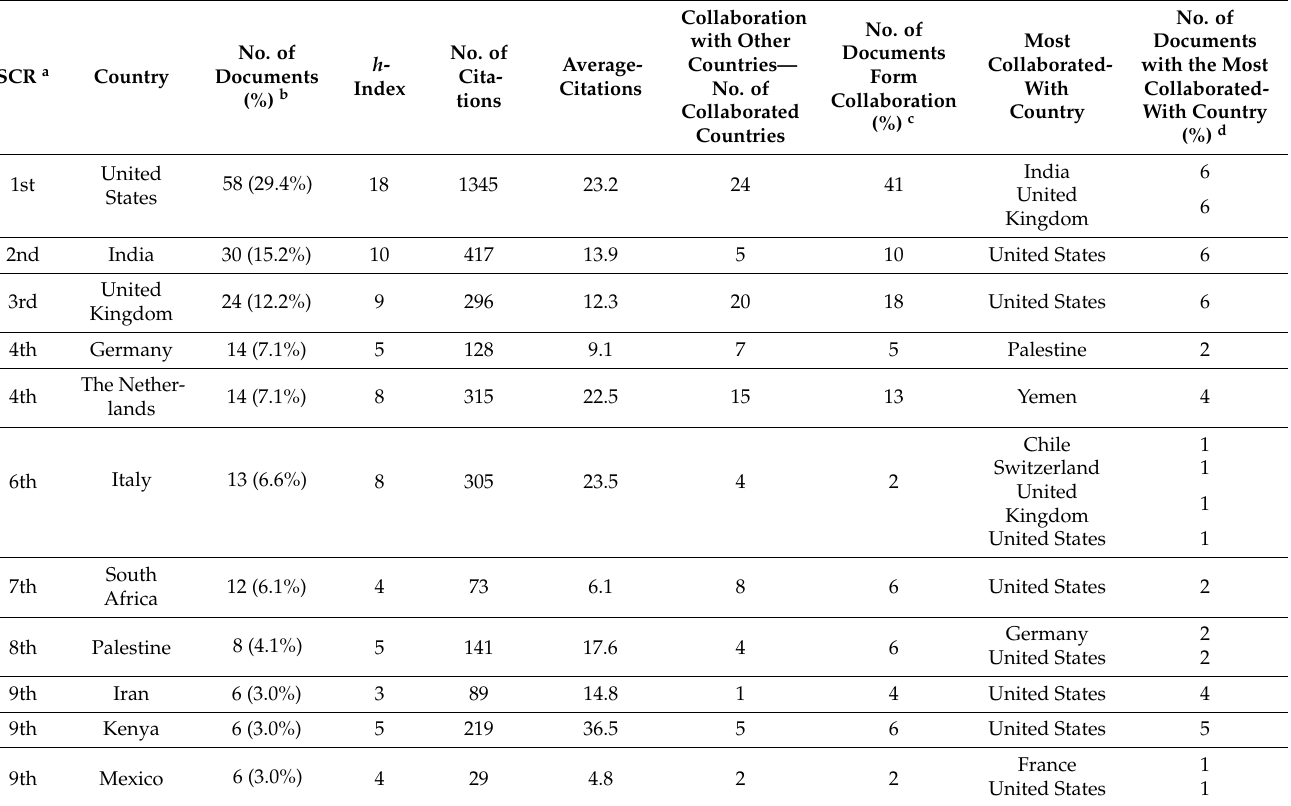
Abbreviations: SCR = Standard Competition Ranking. a Countries with the same output have the same ranking number, and then a gap is left in the ranking numbers. b Percentage of publications/country out of the total published research. c Percentage of publications with international authors out of the total number of documents for each country. d Percentage of publications with the most collaborated-with country out of the total number of documents for each